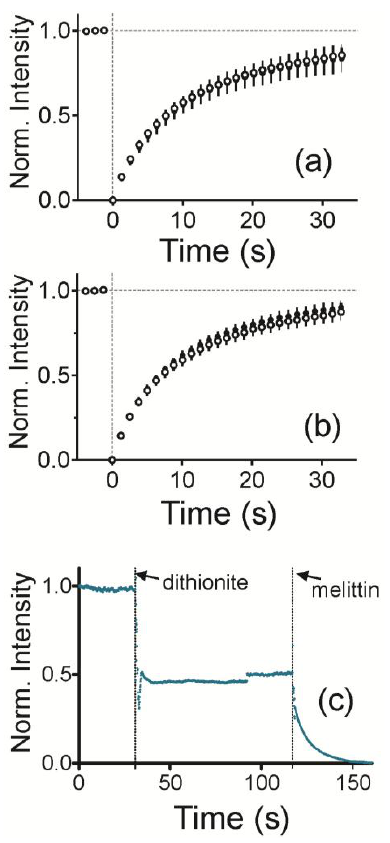
Figure 2. FRAP recovery for a 10 µm diameter region photobleached at time 0 s. ( a ) Fl-HDA (white circles) and Fl-DHPE (black circles) on samples that contain 28 nm ROC; ( b ) Fl-HDA (white circles) and Fl-DHPE (black circles) on samples that contain 55 nm ROC. Error bars are standard deviation; ( c ) NBD-DHPE fluorescence is quenched by dithionite. Once melittin, a pore forming protein, is added, fluorescence decreases to background levels.